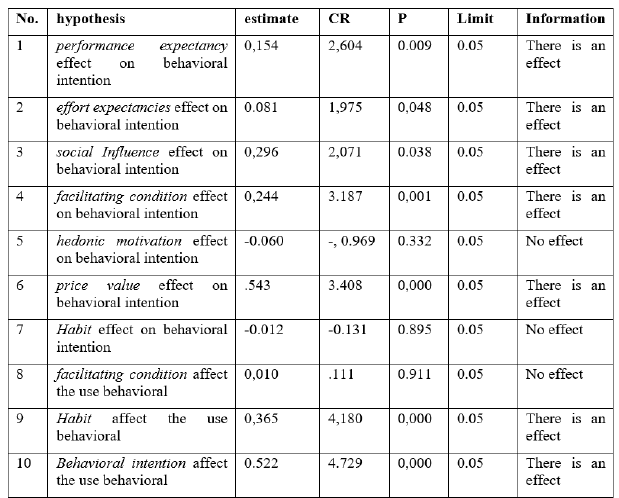
Table 4. Hypothesis Test